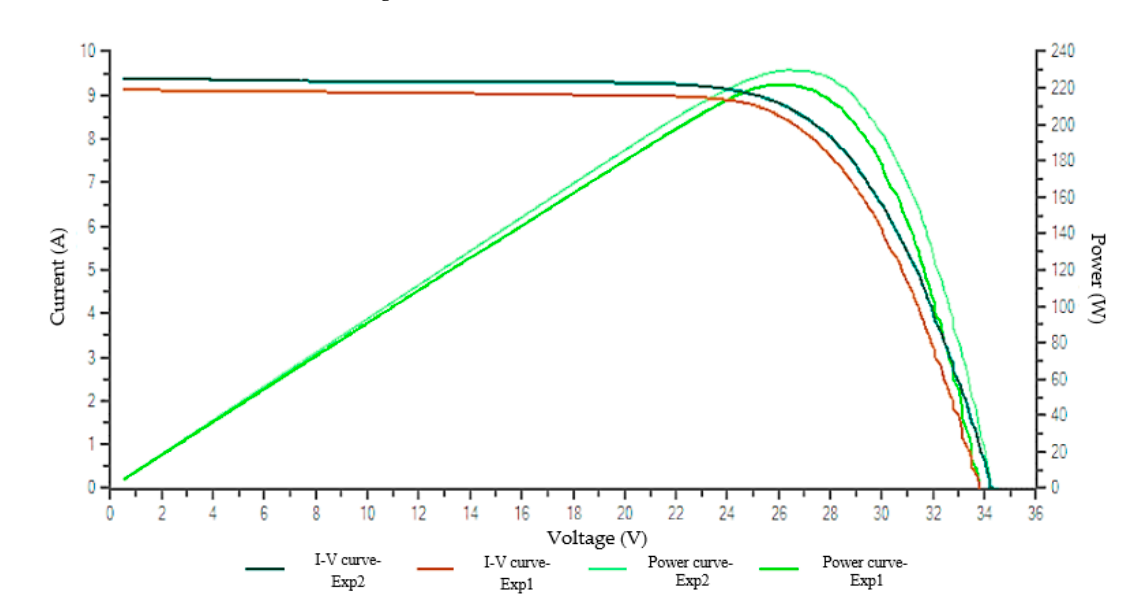
Figure 21. Comparison of V–I and generated power diagrams for tilted panel in experiments 1 and 2.